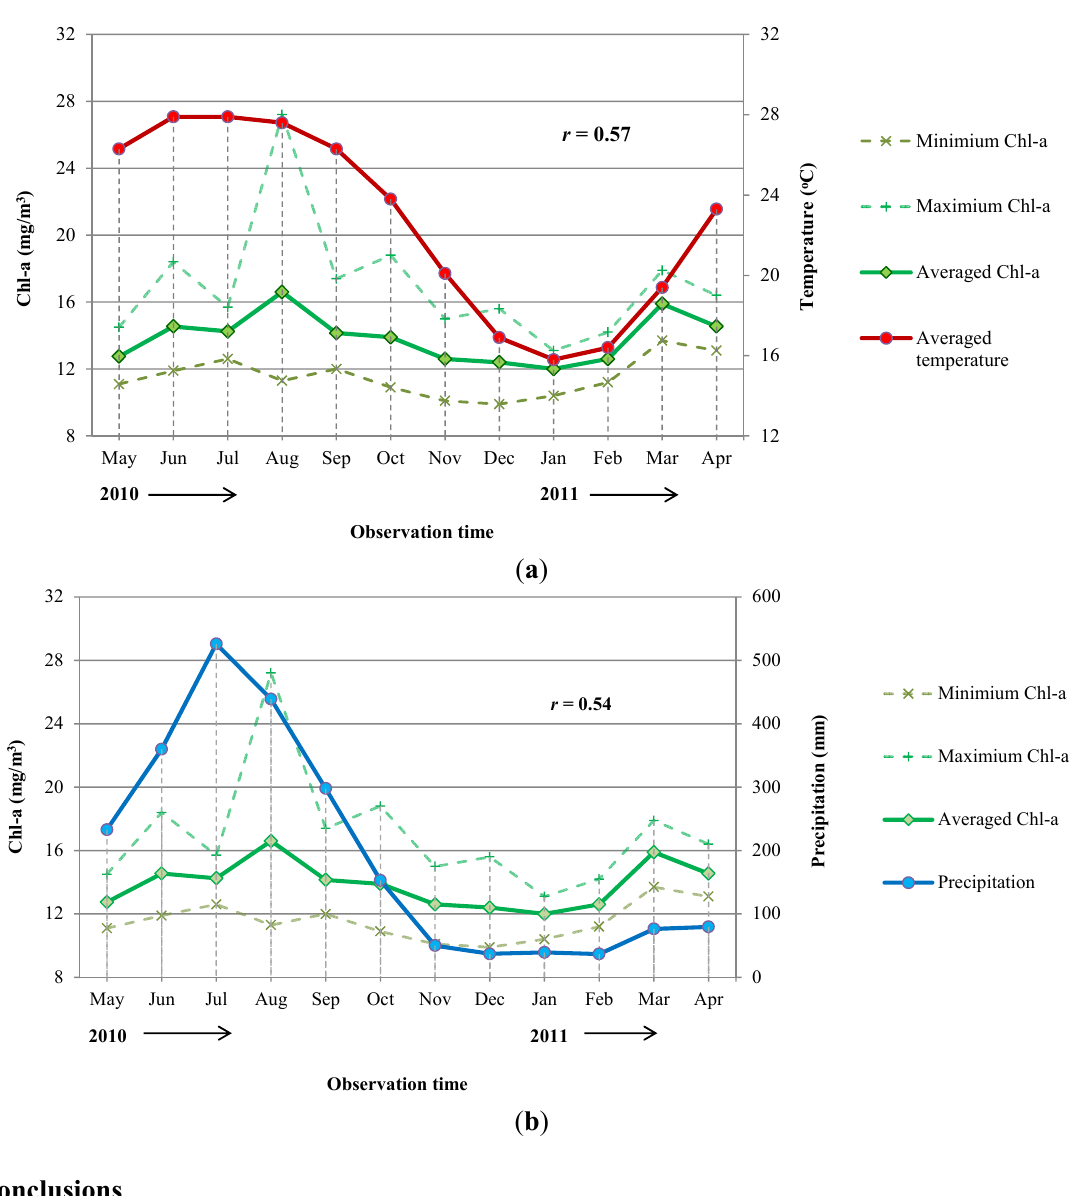
Figure 9. Variations of monthly averaged, maximum and minimum Chl-a concentrations over Tien Yen Bay calculated from the maps in Figure 8 and their correlations with monthly averaged air temperature ( a ) and monthly precipitation ( b ). The r values denote the correlations of the monthly averaged Chl-a concentration with those meteorological